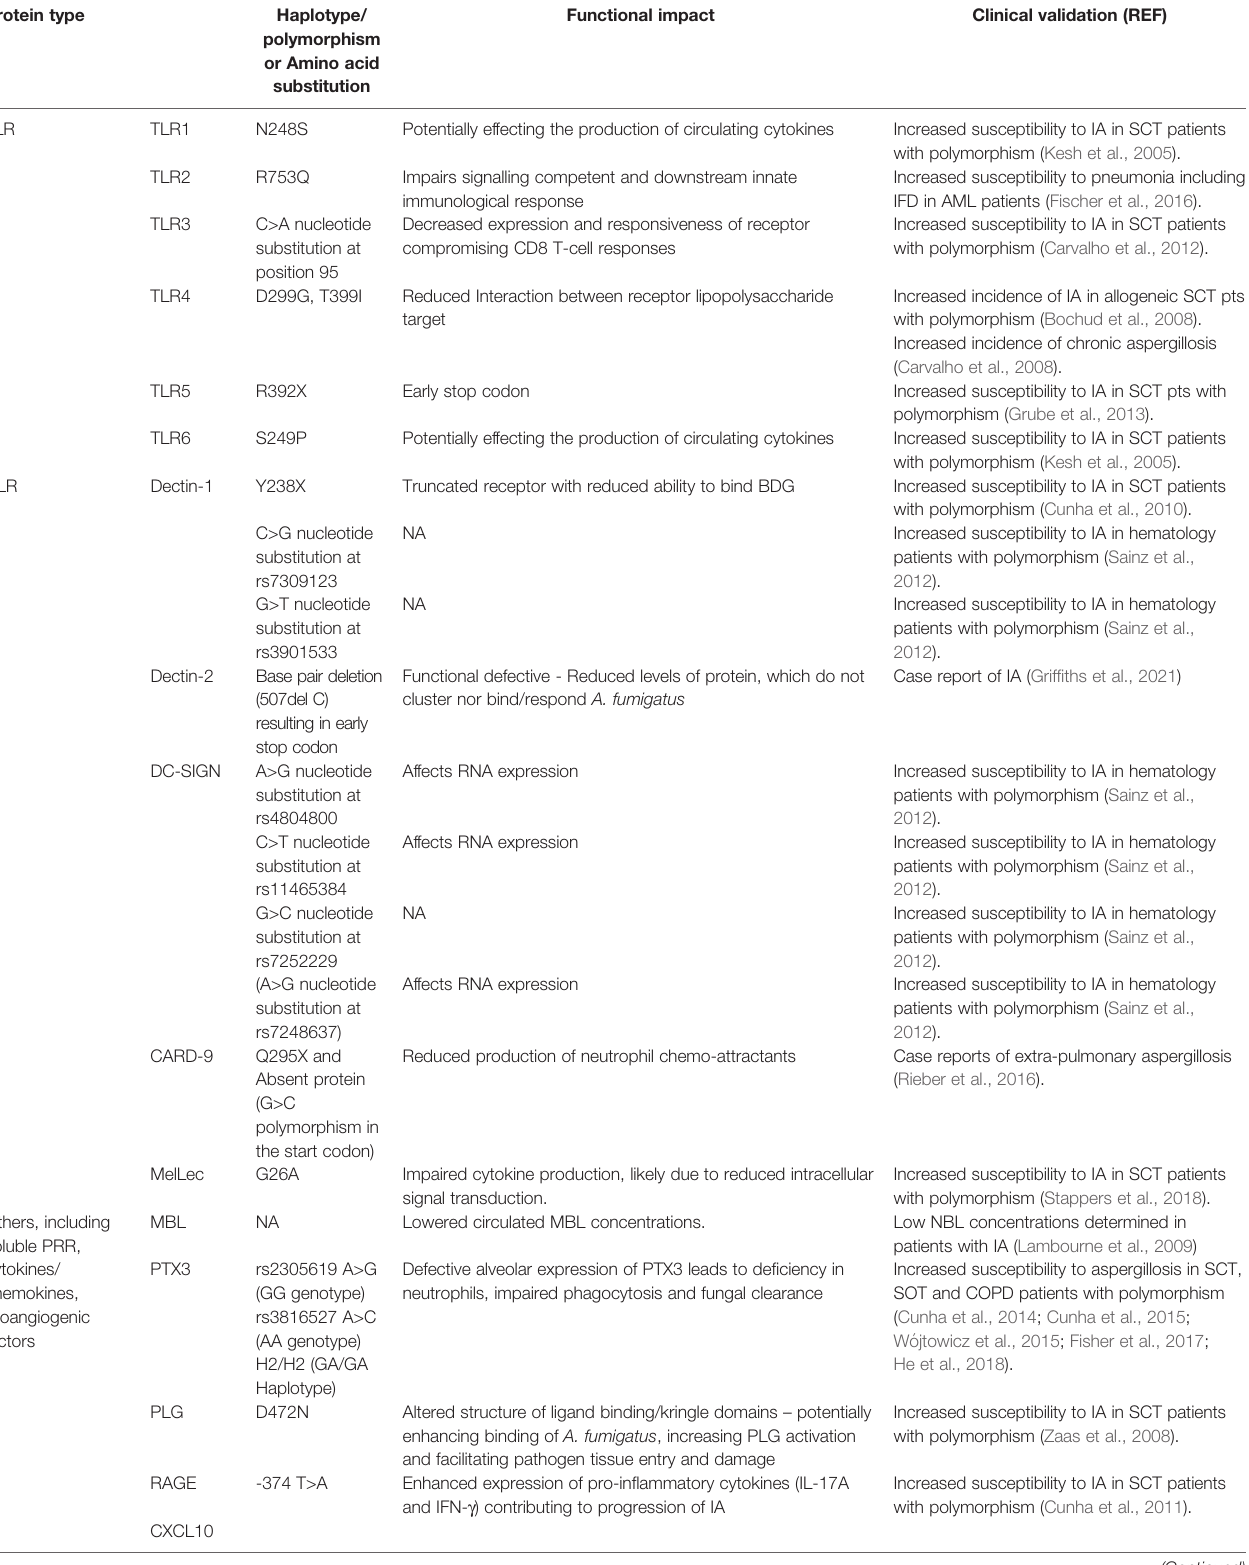
TABLE 1 | A summary of selected genetic variants associated with aspergillosis in various patient cohorts. Protein